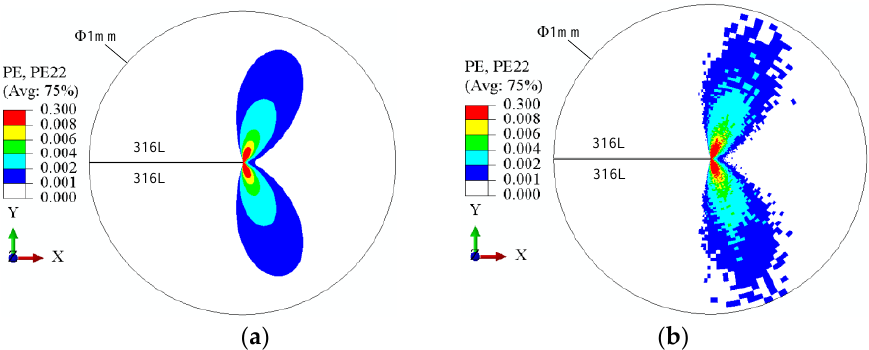
Figure 11. Equivalent plastic strain at the tip of crack 3: ( a ) homogeneous, ( b ) inhomogeneous.